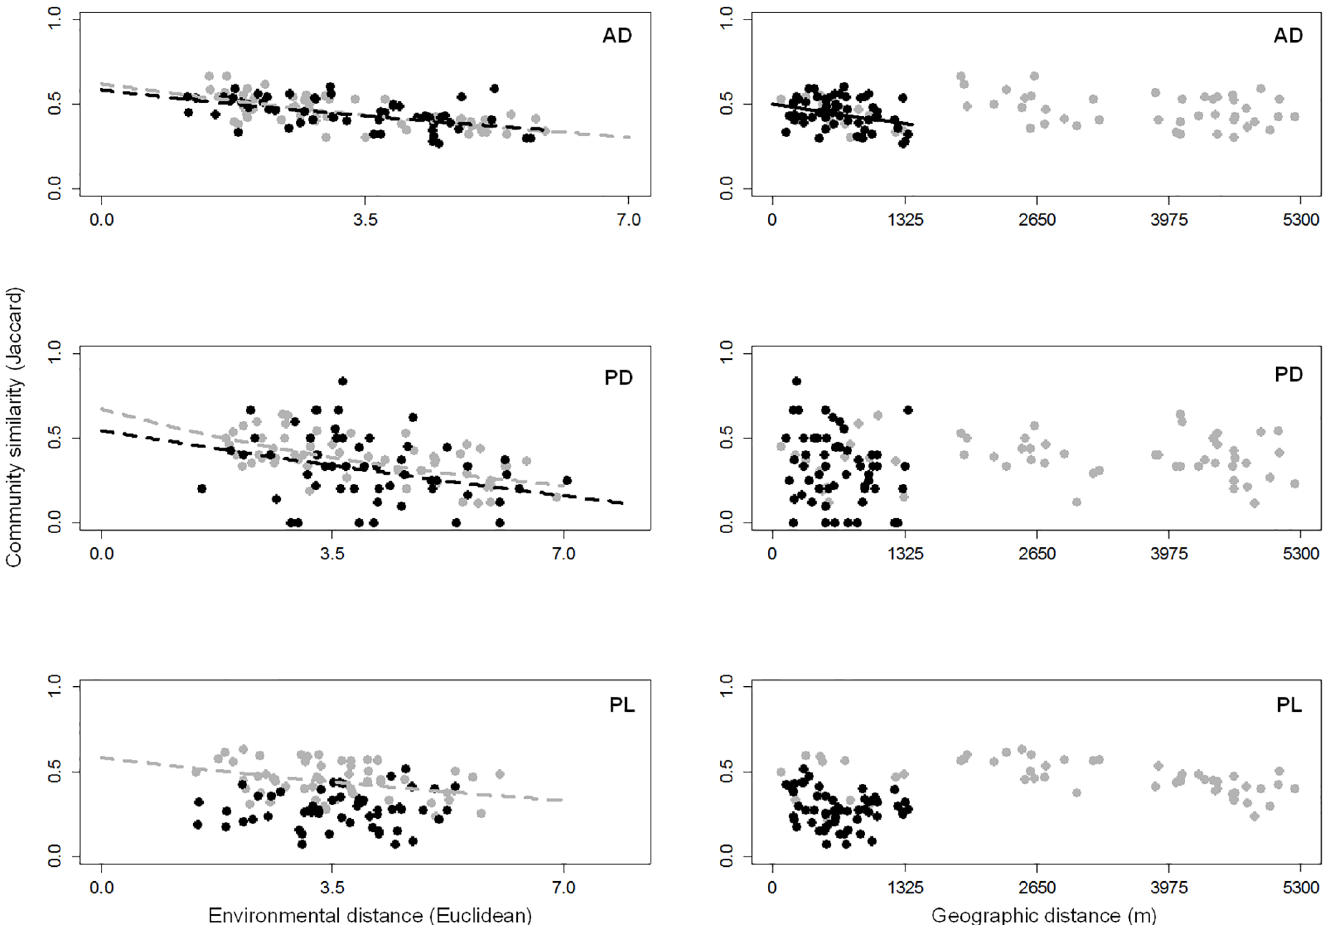
Fig 3. Relationship between community similarity and environmental and geographic distances for AD, PD and PL. Abbreviations are AD (macrofaunal active dispersers), PD (macrofaunal passive dispersers) and PL (plants). The relationship was best approximated by an exponential model in each case (for regression equations see Table 3). Only significant relationships are shown. Black dots and lines are the data from the SEPN (small extent pond network) and grey dots and lines from the LEPN (large extent pond network).